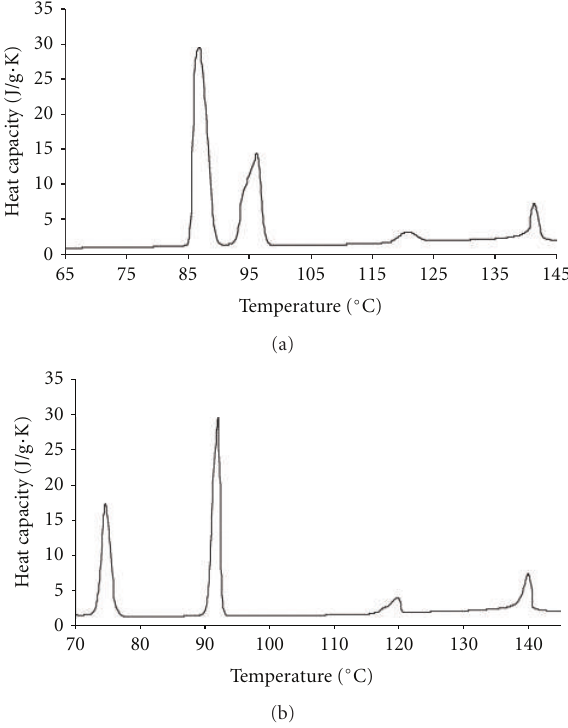
Figure 3: DSC thermograms of 4-(decyloxy)benzoic acid at a rate of 10K · min − 1 , (a) heating, (b)